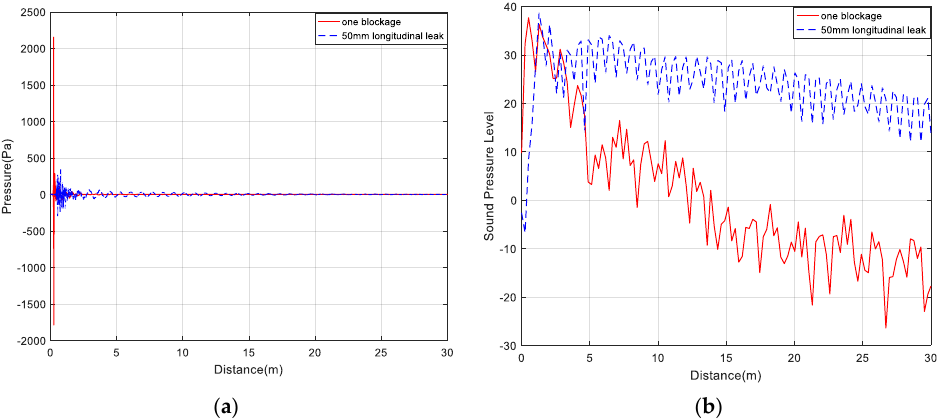
Figure 7. ( a ) Sound pressure of one blockage and 50 mm longitudinal leak; ( b ) SPL of one blockage and 50 mm longitudinal